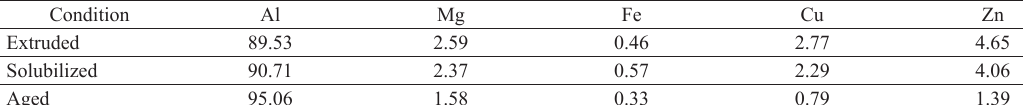
Table 1. EDS values of AA7050 particles in the Al matrix of composite B. Condition